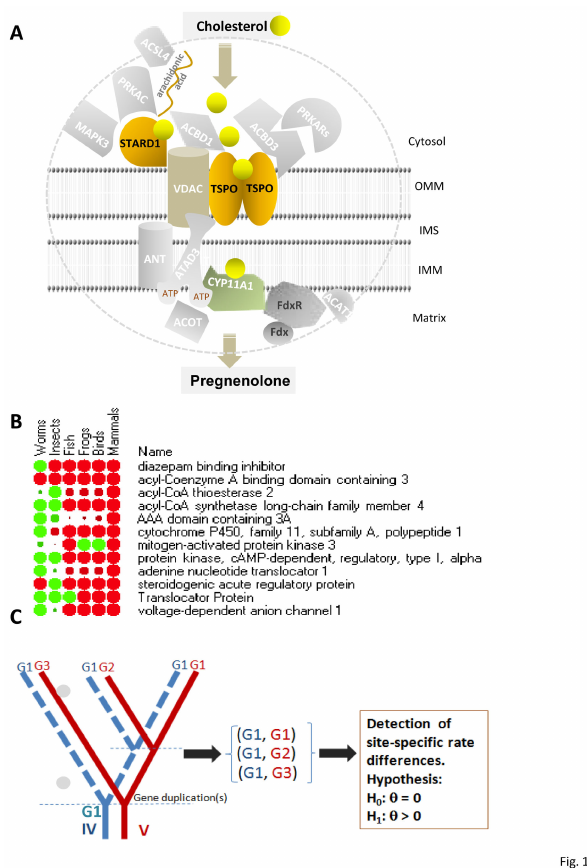
Figure 1. Machinery for mitochondrial cholesterol transport for steroidogenesis and functional prediction. A. Schematic diagram of the transduceosome, steroidogenic metabolon, and associated signal transduction proteins and their likely roles in mitochondrial cholesterol transport and cholesterol metabolism into the first intermediate product, pregnenolone, during steroidogenesis. Each member and the closest members in their corresponding gene family were selected for further evolutionary analysis. IMM, inner mitochondrial membrane; IMS, intermembrane space; OMM, outer mitochondrial membrane. B. Orthologous origin of human TSPO-mediated steroidogenesis complex proteins in other animals. The proteins include Translocator Protein 18- kDa (TSPO) previously known as peripheral benzodiazepine receptor (PBR or BZRP), steroidogenic acute regulatory protein (STAR) or START domain containing 1 (STAR/STARD1), acyl-CoA binding domain containing 3 or PBR- and PKA-associated protein 7 (ACBD3/PAP7), cytochrome P450, family 11, subfamily A, polypeptide 1 (CYP11A1), acyl-CoA binding domain containing 1 or diazepam binding inhibitor (GABA receptor modulator, acyl-CoA binding protein; ACBD1/DBI), protein kinase, cAMP- dependent, regulatory, type I, alpha (PRKAR1A), ATPase family, AAA domain containing 3A (ATAD3), mitogen-activated protein kinase 3 or extracellular signal-regulated kinase ½ (MAPK3/ERK1/2), acyl-CoA synthetase long-chain family member 4 (ACSL4), acyl-CoA thioesterase 2/3 (ACOT2/3), voltage-dependent anion channel 1 (VDAC1), adenine nucleotide translocator 1 or solute carrier family 25 (mitochondrial carrier; adenine nucleotide translocator), member 4 (ANT1/SLC25A4). BLAST expectation value ( e - value), a statistical calculation based on the score that gives the number of hits that this search would return by chance in a genome database, was used in the ranking of the best matches (“hits”) from the database. A higher e-value may suggest a distant evolutionary relationship. The max identity (percent similarity between the query and subject sequences over the length of the coverage area) was used to show the occurrence of the proteins in the organism as ink blots of the heatmap where the diameter of each dot corresponds to the value. That is, the ink blot is smallest exactly halfway between the minimum and maximum values and becomes progressively larger as the values approach the minimum or maximum. Green to red indicates the value (%) from smaller to bigger. The data was normalized in each row. C. The in silico prediction of functional divergence in protein evolution by site- specific rate shifts using the maximum likelihood method in DIVERGE [29]. G1-G3, paralogous gene number 1 to 3; IV, invertebrate; V, vertebrate; H and H , hypothesis of the type I evolutionary functional divergence using a coefficient of statistical divergence (θ), 0 1 which is the change in function that resulted from different rates at these sites between clusters. If the null hypothesis of θ = 0 was not rejected, the evolutionary rate is virtually the same between two clusters of genes, and this result implies that these clusters share the same function(s). The dotted line indicates that gene duplication did not occur. doi: 10.1371/journal.pone.0076701.g001 PLOS ONE |